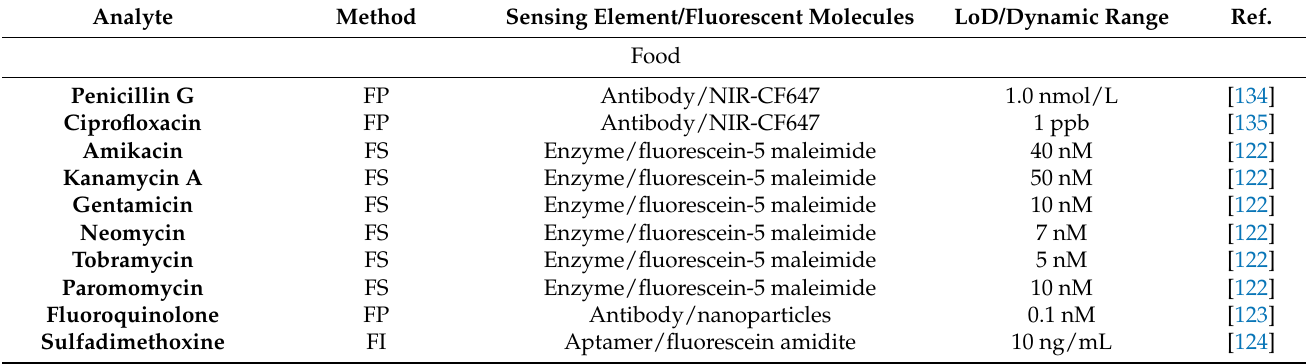
Table 2. List of analyte targets detected by fluorescence-based